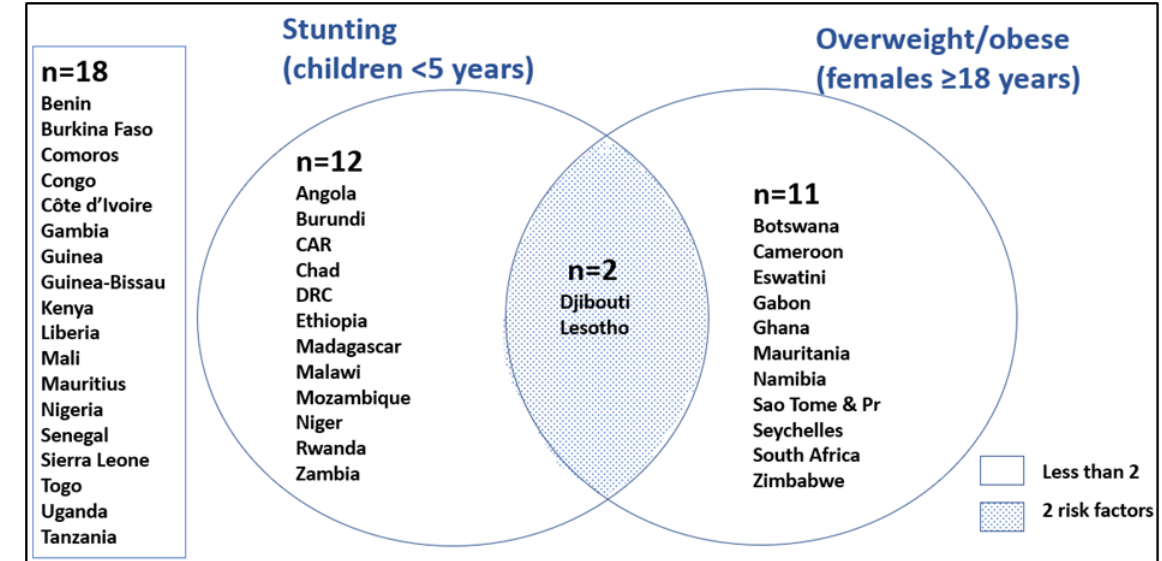
Figure 7. A Venn diagram showing the double burden of malnutrition in SSA countries illustrated by under-five child stunting and women overweight/obese (only those in the top tertile are in the diagram).